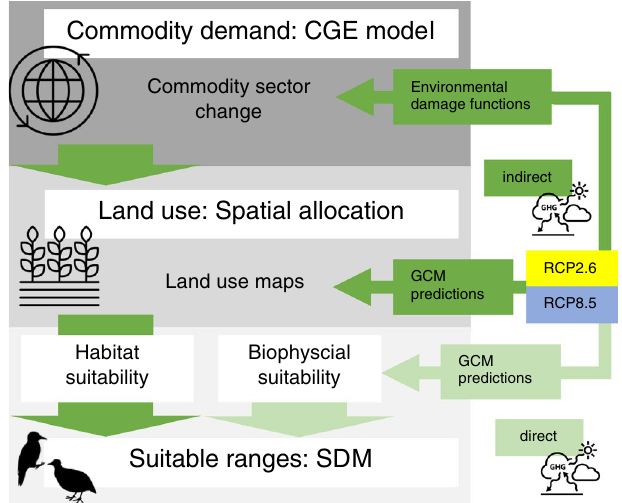
Figure 1. Overview of the modelling framework to capture interactions between direct and indirect drivers of biodiversity change under climate change scenarios. We included two Representative Concentration Pathways RCP2.6 and RCP8.5 to characterize the plausible extremes of climate change. Dark green arrows represent the indirect pathway of climate change impacts on suitable ranges. Light green arrows indicate the direct pathway of climate change impacts on ecological suitability. Icons from